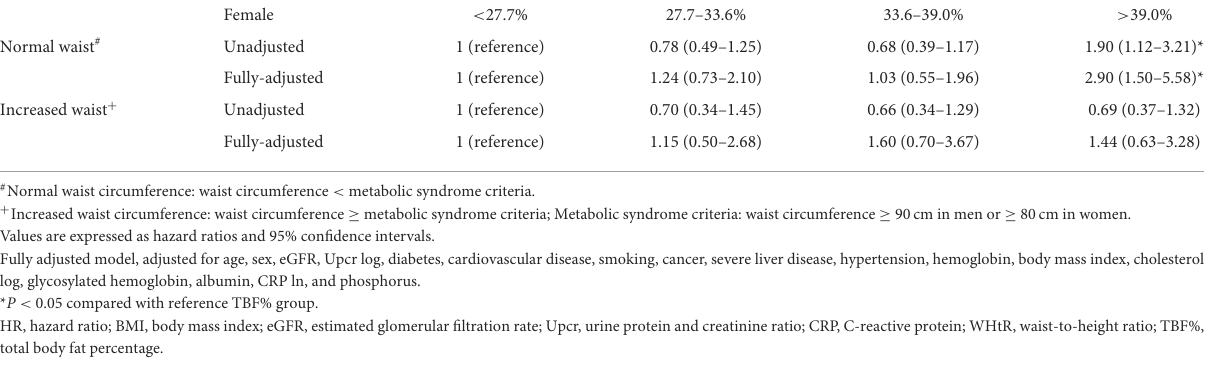
TABLE 6 Hazard ratios for all-cause mortality based on total body fat percentage, body mass index and waist